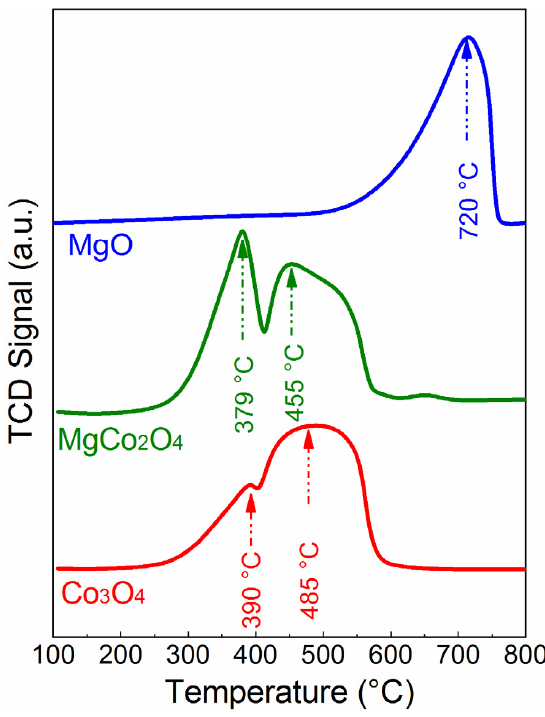
Figure 6. H 2 -TPR profiles of Co 3 O 4 , MgCo 2 O 4 and MgO